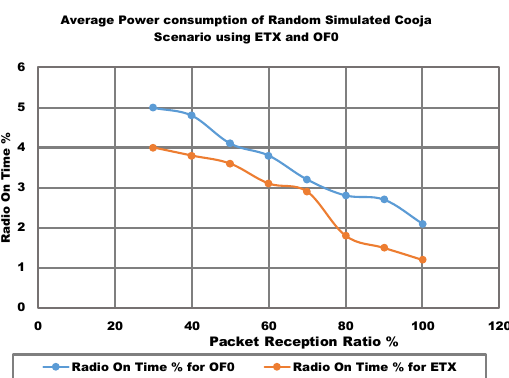
Figure 18. Average power consumption in Cooja simulator for OF0 and ETX with random Figure18. Average power consumption in Cooja simulator for OF0 and ETX with random RPL RPL topology. topology.